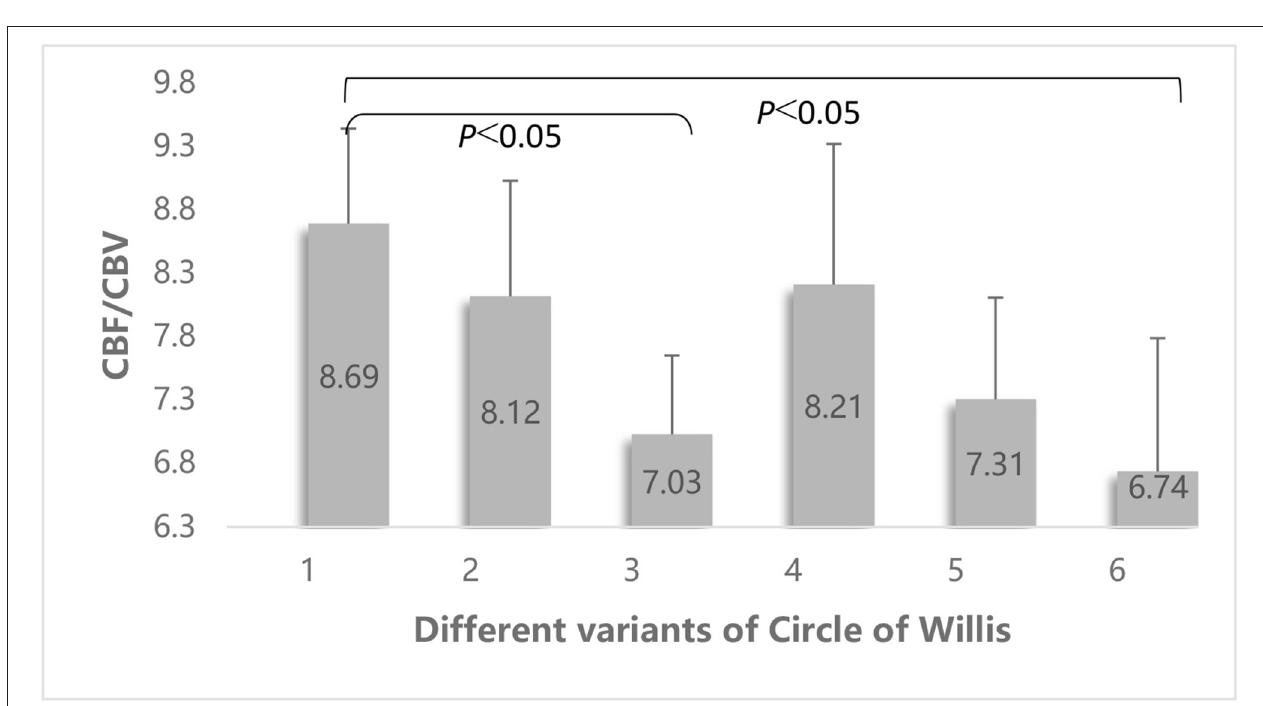
FIGURE 5 | Comparison of the differences of the CBF/CBV value among different vascular variants of the circle of Willis. Different vascular variants of the circle of Willis: 1 = no variation; 2 = no ipsilateral PCoA; 3 = ipsilateral FTP; 4 = no ipsilateral ACA-A1; 5 = no ipsilateral PCoA and incomplete anterior circulation; 6 = ipsilateral FTP and incomplete anterior